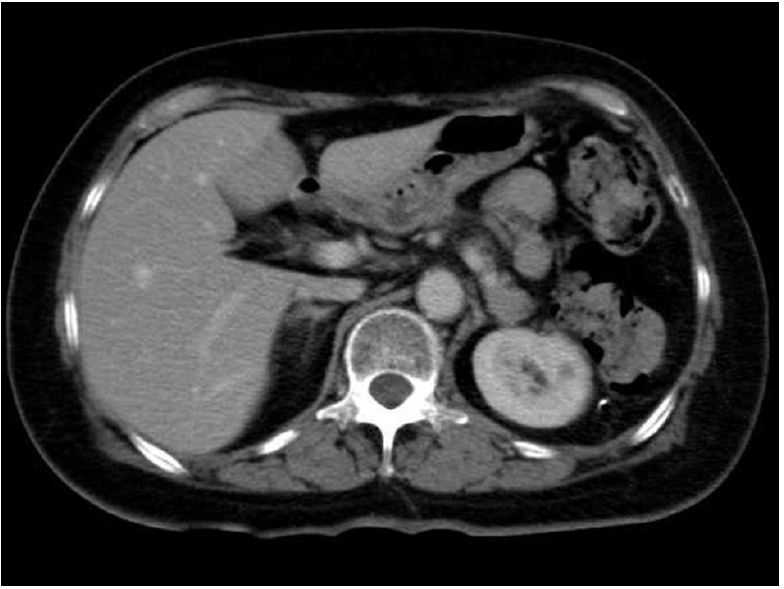
Figure 3. Ten years after removal of the left adrenal tumor, there are no abnormal findings on CT.